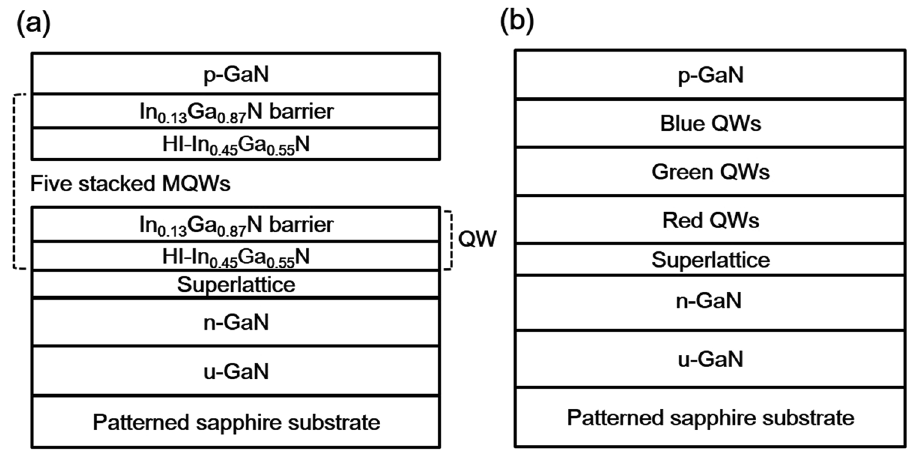
Figure 1. Schematic structures of ( a ) the RLED and ( b )